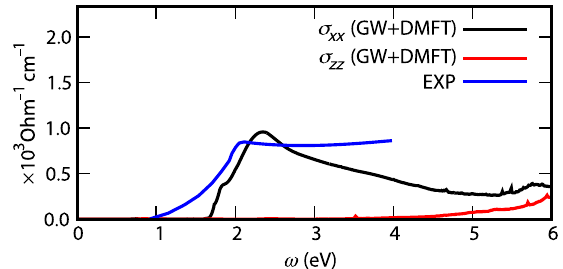
FIG. 4. Optics: theoretical optical conductivity σ ð ω Þ obtained with the QS GW þ DMFT approach for the in-plane ( σ xx ) and out-of-plane components ( σ zz ). We emphasize that these results are a prediction from an essentially ab initio Hamiltonian. We obtain remarkable agreement with experimental data, reproduced from Ref. [19], which validates the theoretical